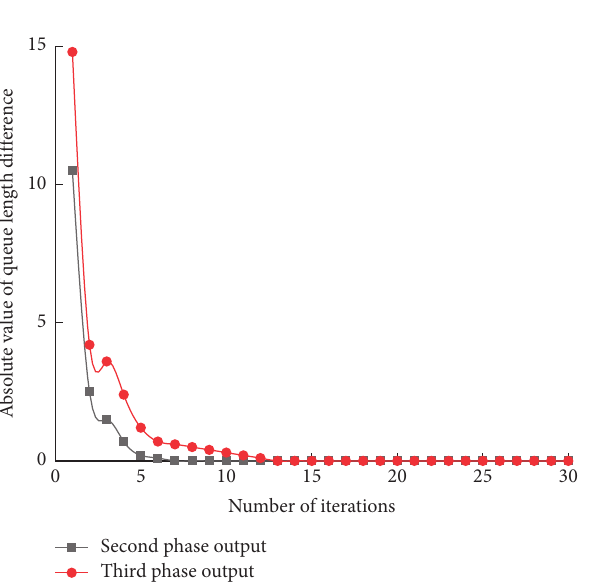
Figure 4: Queue length difference of iterative learning control.